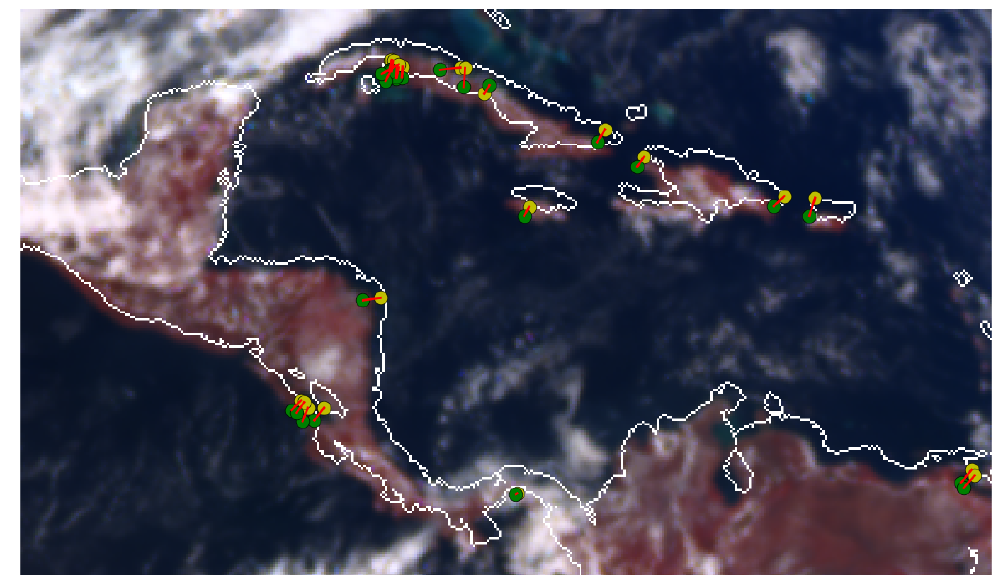
Figure 4. Pairs of matching keypoints found within one of the regions shown in Figure 1 after applying the outlier rejection step based on spatial criteria. The keypoints detected in the theoretical coastline (white lines) are shown as yellow points, while the corresponding keypoints detected in the radiometric coastline are shown as green points. Every matching pair is connected with a red